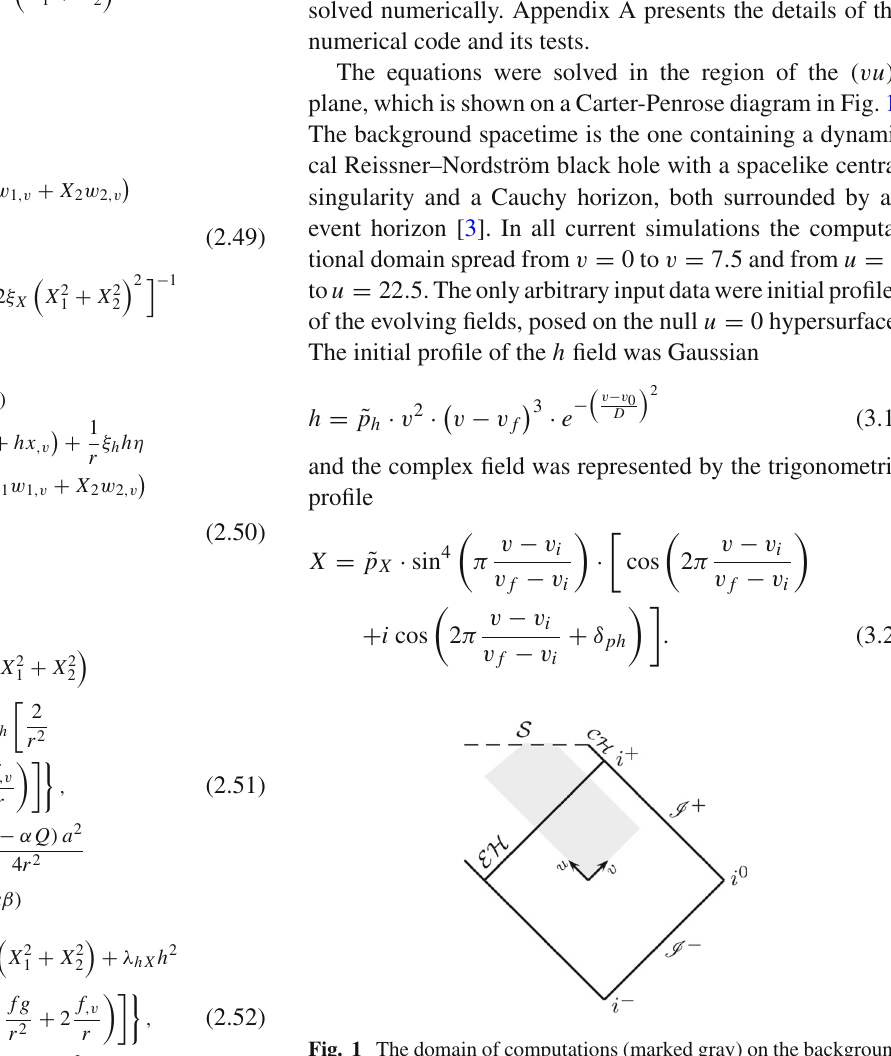
Fig. 1 The domain of computations (marked gray) on the background of the Carter–Penrose diagram of the dynamical Reissner–Nordström spacetime. S , EH and CH are the central singularity along r = 0, the event and Cauchy horizons, respectively. The infinities I ± , i ± and i 0 are null, timelike and spacelike,